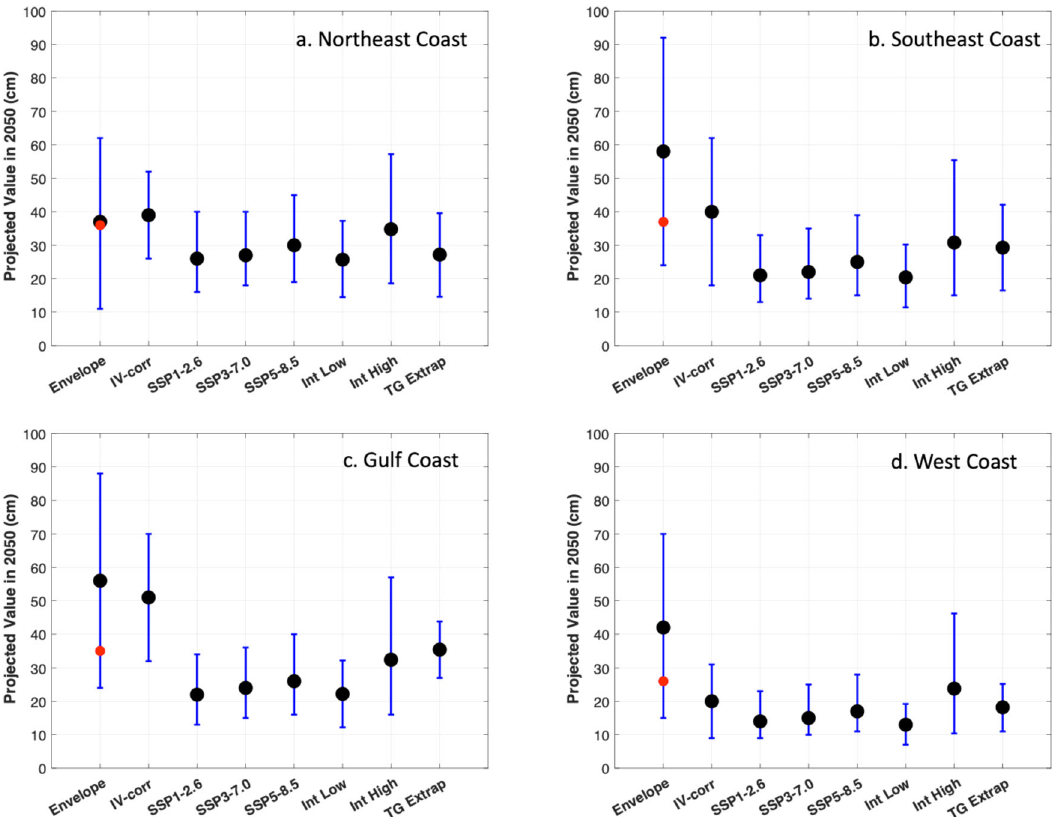
Fig. 6 Future sea level change estimates, 2020-2050. Sea level change from 2020 to 2050 for four different regions along the coastlines of the United States: ( a ) Northeast Coast, ( b ) Southeast Coast, ( c ) Gulf Coast, ( d ) West Coast obtained from the observations and IPCC AR6 and Interagency Task Force Technical Report. Black circles indicate median estimates and blue lines indicate the 90% con fi dence interval on each estimate. Two observation- based approaches are shown: the enveloping approach and the internal variability (IV-corr) approach. The red circle represents the internal variability correction value using the enveloping approach (using black dashed lines in Figs. 3 and 4). TG Extrap is the tide gauge extrapolation from the Interagency Sea Level Task Force report for the U.S.